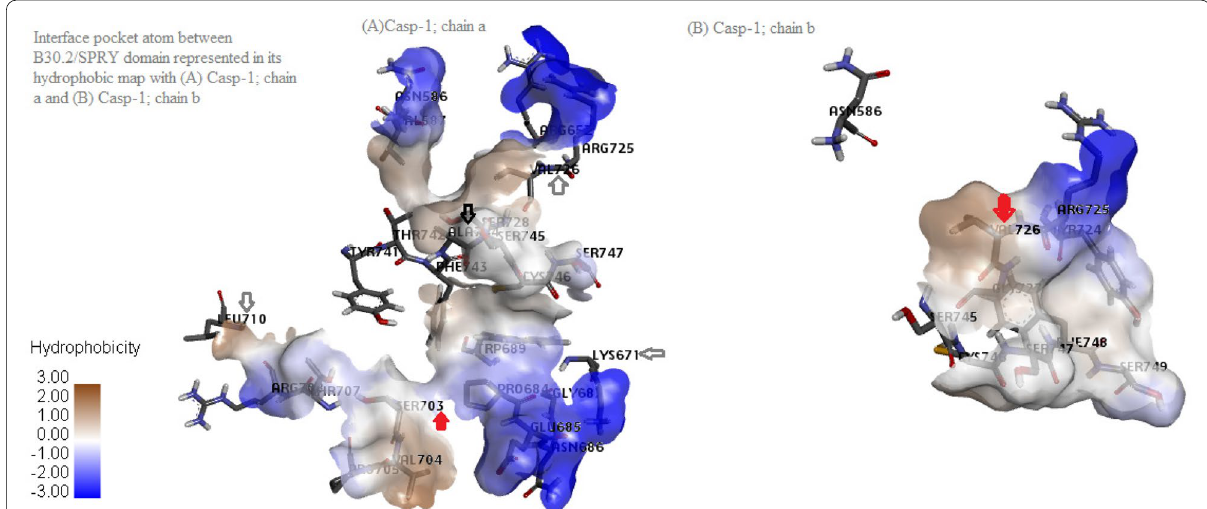
Fig. 4 Interface pocket amino acids between B30.2/SPRY and both p20 ( A ) and p10 ( B ) subunits of Casp‑1 protein. The contributed amino acids inside the interface pocket divided to interacted residues (non‑covalent bonding residues) and nearby ones (bonding scale <5 A° between its Cα atom and that of a surface residue as default setting). Out of the 13 retrieved variants, the interface nearby residues were arrowed by non‑filled arrows, and the interacted ones were arrowed by the red filled arrows (B30.2/SPRY:Ser703 with casp1‑p20:Ser175 ) & (casp1‑p20:Val338 ‑ B30.2/ SPRY:Val726. CHARMM52 force field was applied and implemented in the prism